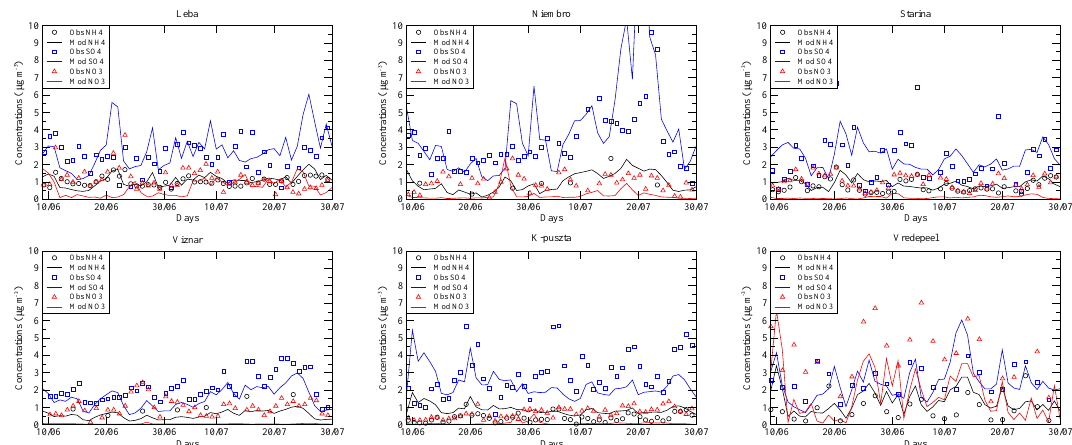
Figure 7. Time series of PM 10 (µgm − 3 ) for the modeled and measured surface inorganic species.